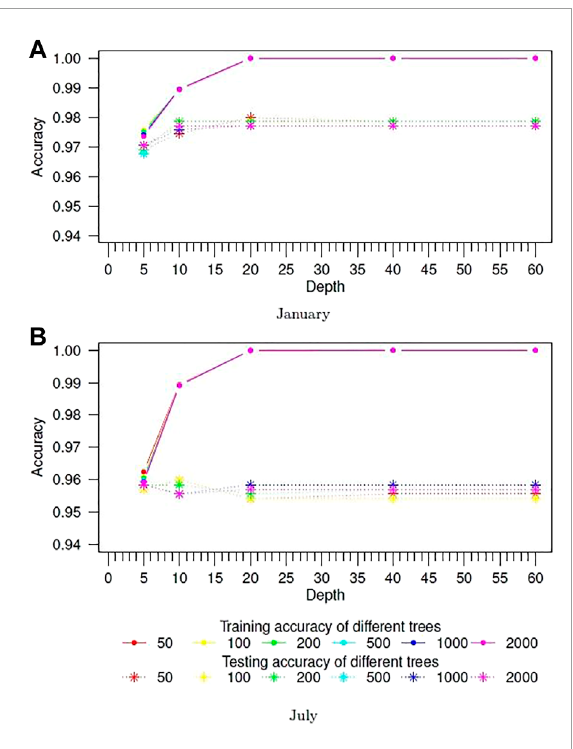
FIGURE 4 Peak hour RF model hyper-parameter tuning for (A) January and (B)